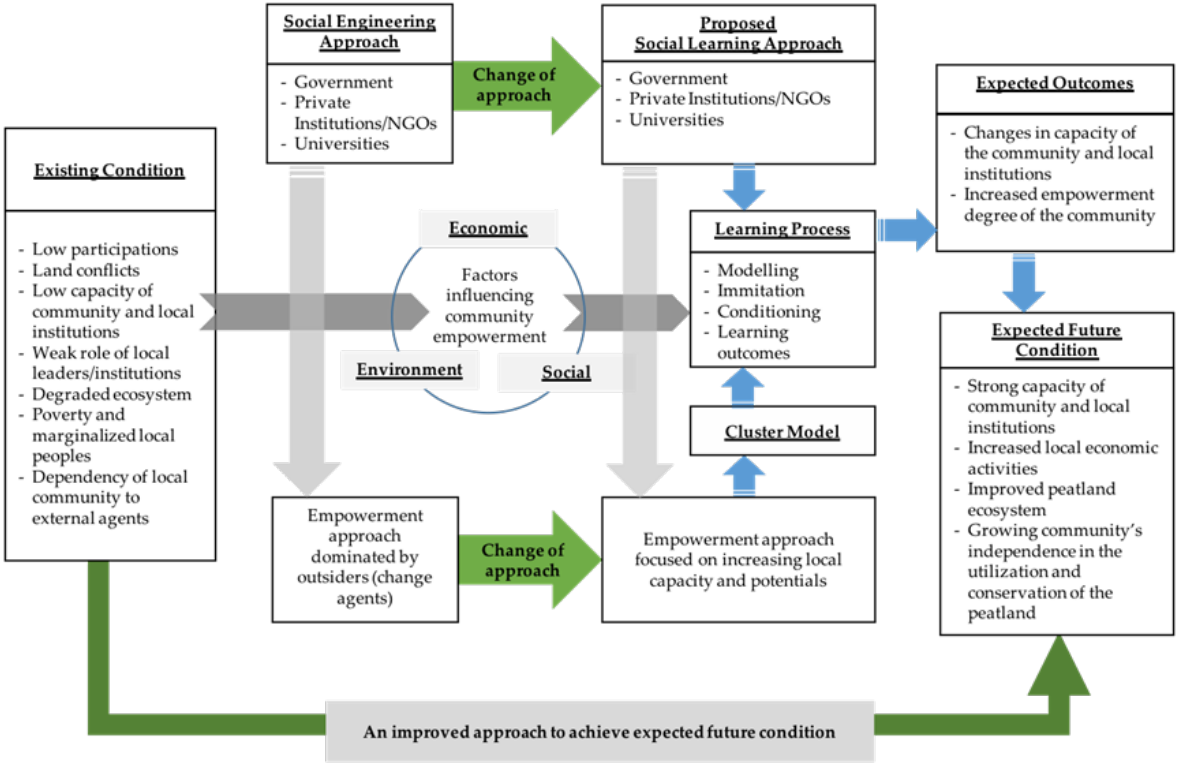
Figure 4. Proposed mechanism for more effective empowerment of the local community to carry out peatland restoration in the Aceh peat swamp